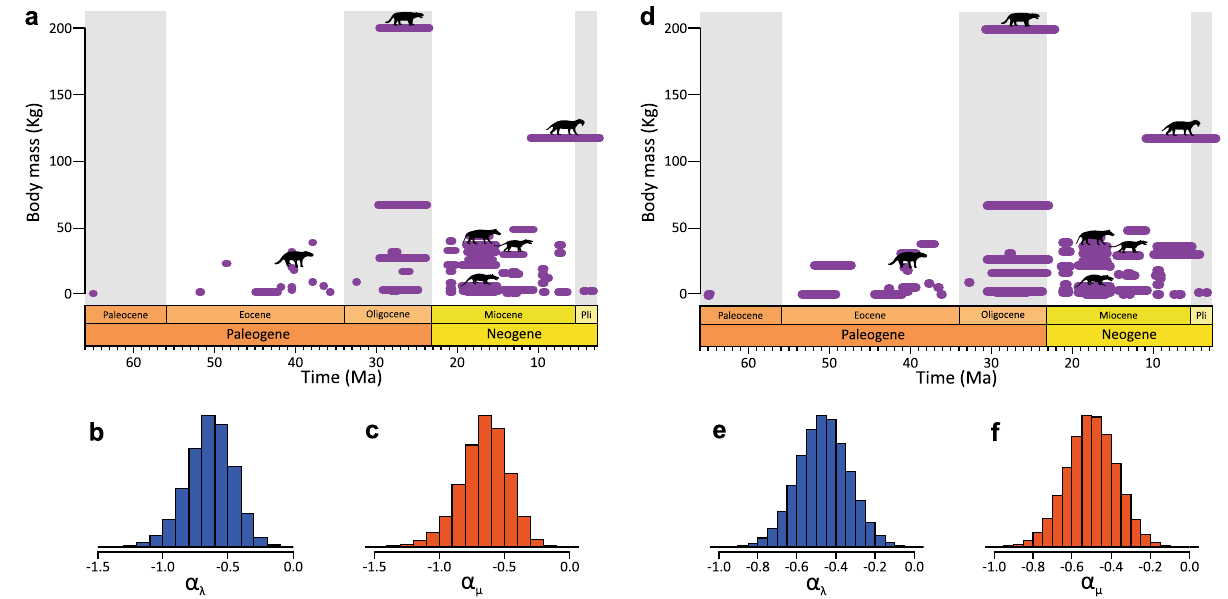
Figure 2. Correlations between diversification dynamics and body mass evolution in Sparassodonta. Analysis from the species occurrence dataset ( a – c ) and the fossil specimens dataset ( d – f ). The reconstructed life span of species obtained from one of 20 replicated analyses from the species occurrence dataset ( a ) and the fossil specimens dataset ( d ). Correlation between changes in body mass and speciation rate (α λ ) from the species occurrence dataset ( b ) and the fossil specimens dataset ( e ). Correlation between changes in body mass and extinction rate (α μ ) from the species occurrence dataset ( c ) and the fossil specimens dataset ( f ). Representative silhouettes of Sparassodonta with different body mass are taken from PhyloPic: Borhyaena tuberata , Callistoe vincei , Cladosictis patagonica , Lycopsis longirostrus , Proborhyaena gigantea , and Thylacosmilus atrox designed by Zimices and licensed under the Creative Commons Attribution 3.0 Unported license (http:// creat iveco mmons. org/ licen ses/ by/3.